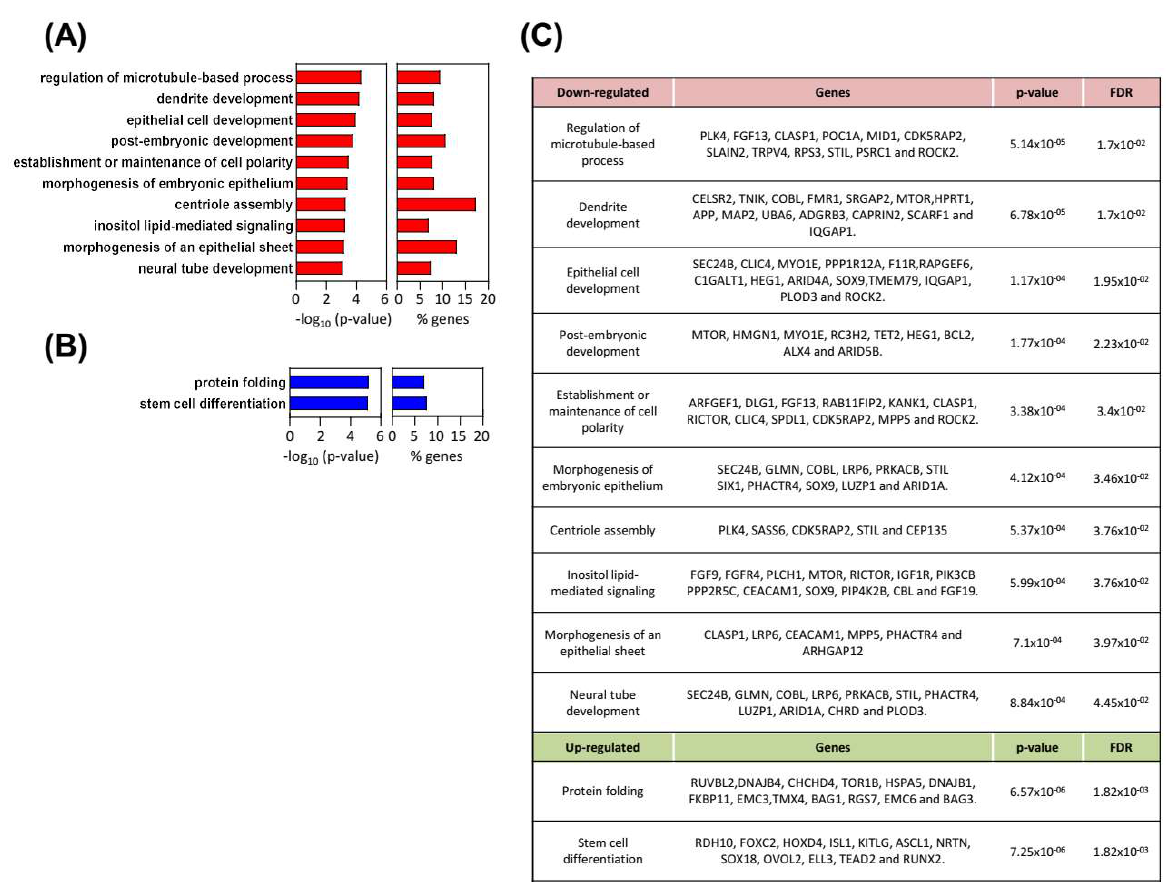
Figure 5. Multiple biological processes differentially expressed in SOX9 -silenced cells. ( A , B ) Biological processes (BPs) altered in shSOX9 RWP-1 cells. Gene ontology enrichment analysis from the